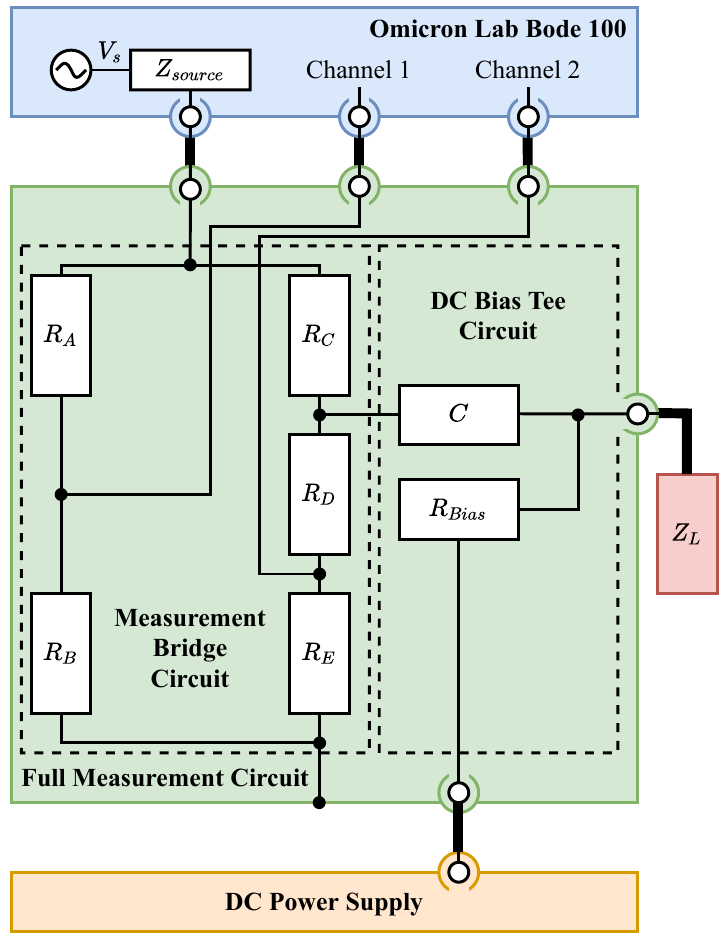
Figure 17. Block diagram of the measurement setup for DC-biased AC small-signal analysis. Table 3. Component values for the full measurement